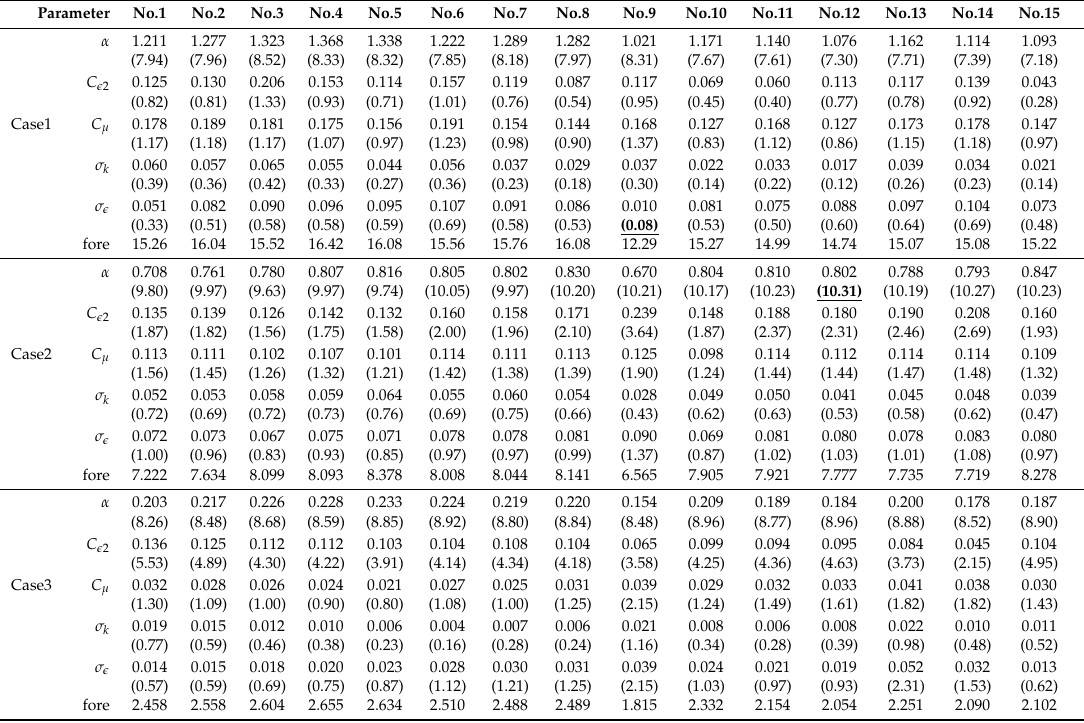
Table 4. The standard deviation (STD) values of the wind speed (m/s) for three cases at 15 turbine sites. The relative sensitivity (%) against the deterministic forecasts of the hub height wind is shown in parentheses.